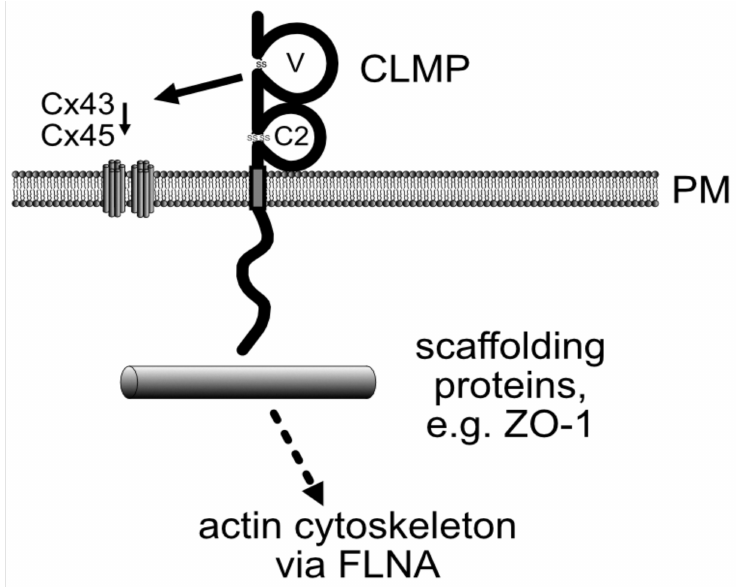
Figure 4. Scheme showing hypothetical molecular functions of CLMP in smooth muscle cells of the murine intestine. The absence of CLMP results in a severe reduction of connexin-43 and 45-containing gap junctions in the circular smooth muscle layer. As discussed, CLMP might also interact—directly or indirectly—with the cytoskeleton. This might also include filamin A—an actin bundling protein. The binding of the cytoplasmic segment of CLMP to a scaffolding protein such as ZO-1 or to the actin cytoskeleton must be tested